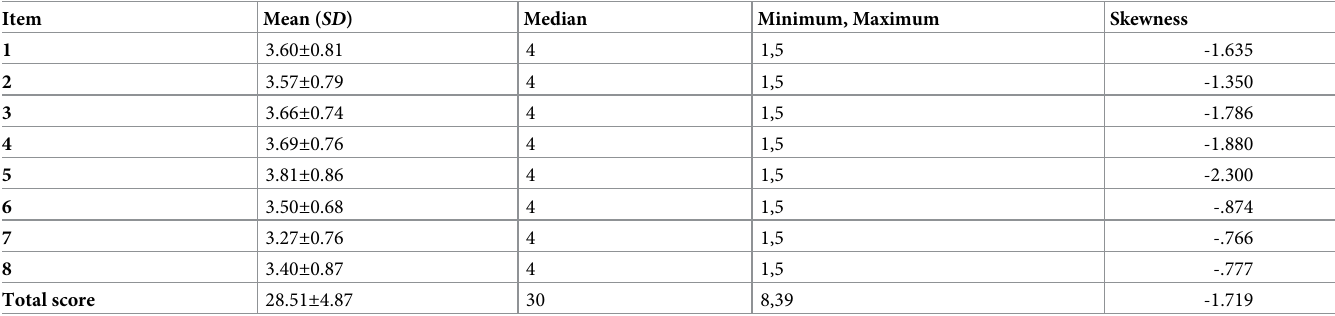
Table 2. Descriptive statistics and inter-item correlation of Si-eHEALS (n =